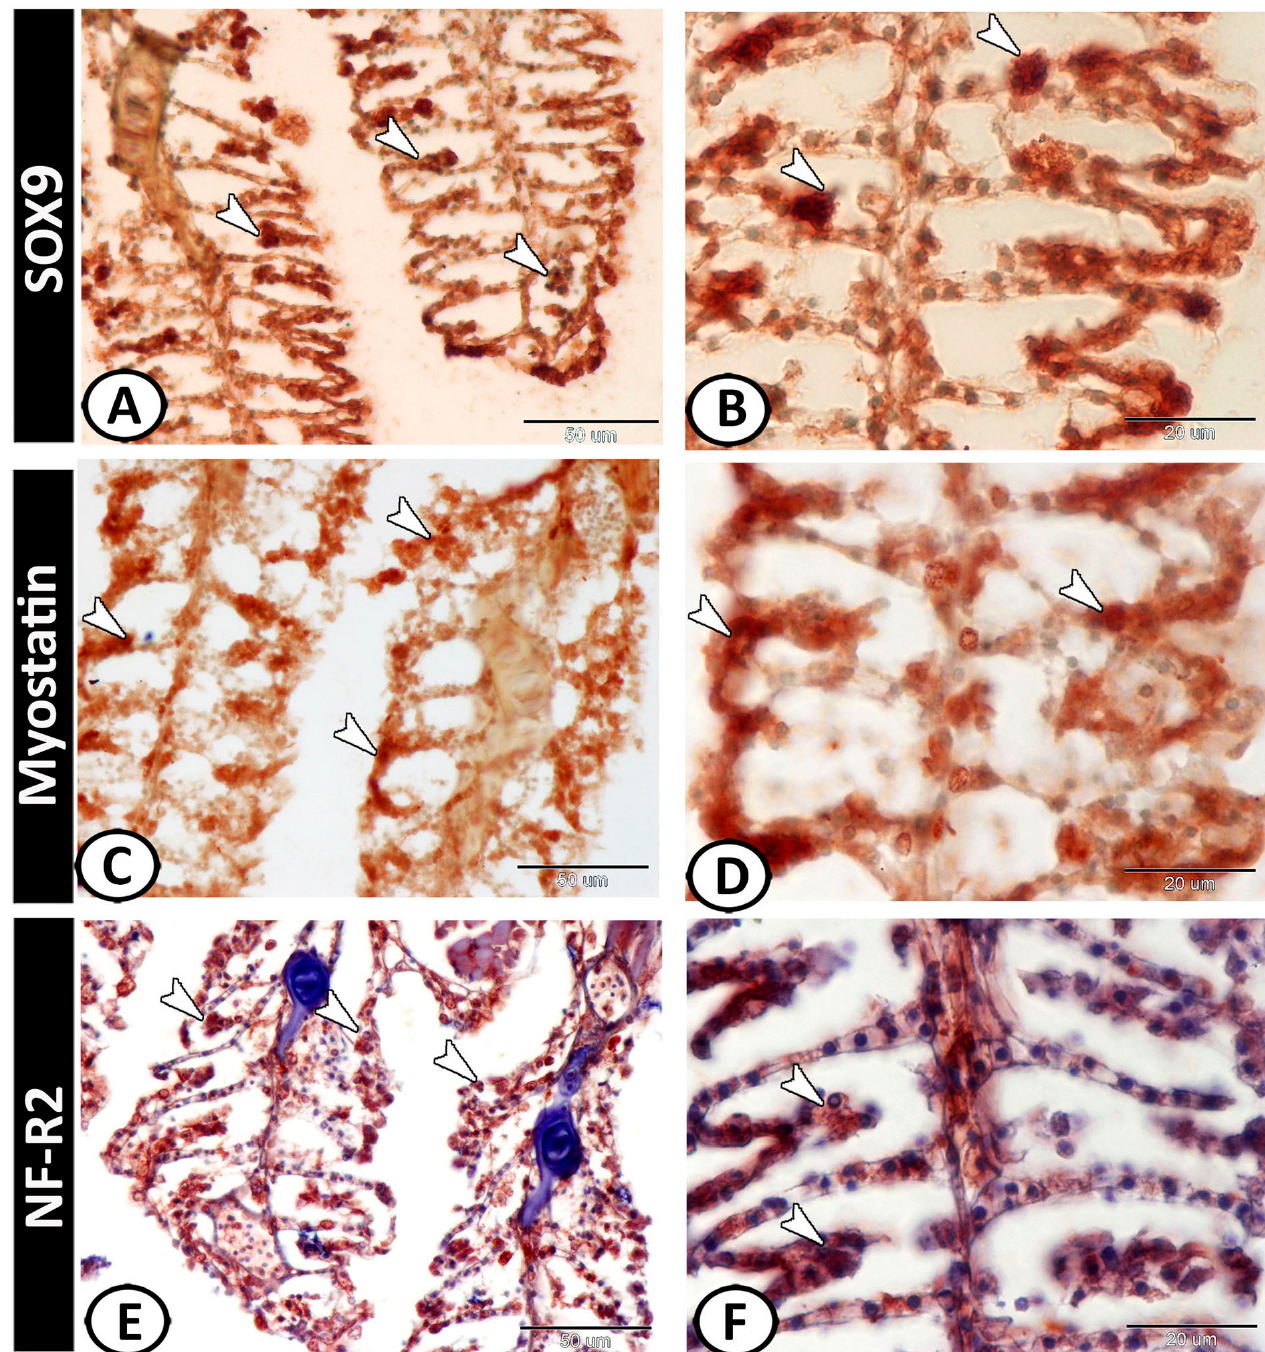
Figure 6. Immunohistochemistry of SOX9, myostatin, and Nrf2. ( A , B ) The stem cells expressed SOX9 (arrowheads). ( C , D ) The stem cells expressed myostatin (arrowheads). ( E , F ) The stem cells expressed Nrf2 (arrowheads).